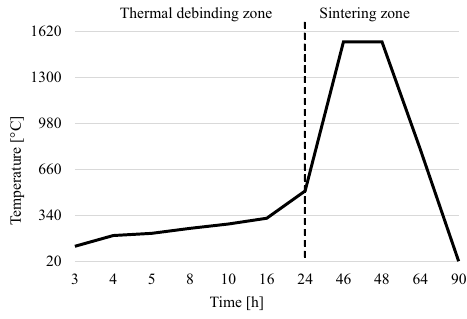
Figure 6. Thermal debinding and sintering